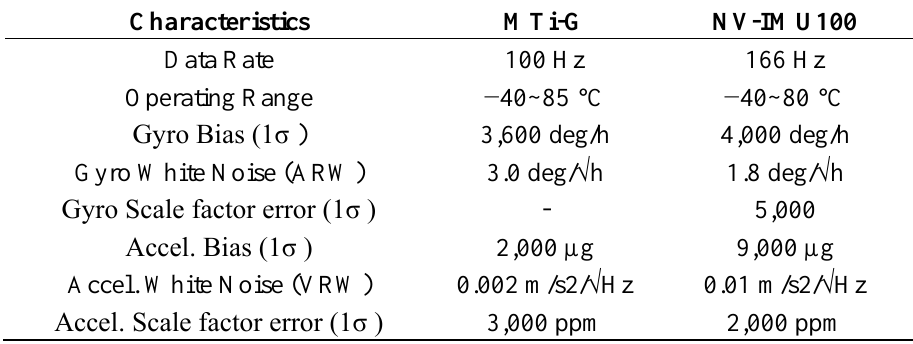
Table 3. Characteristics of tested